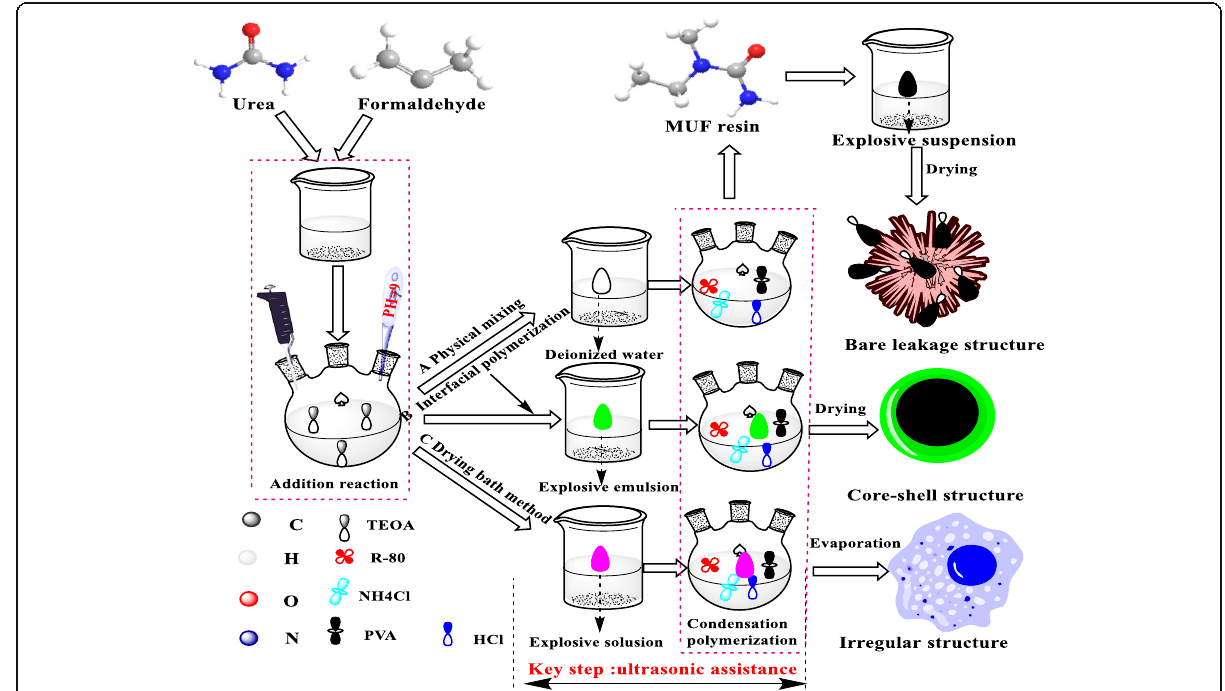
Fig. 2 Schematic diagram of different methods for preparing HMX/MUF, RDX/MUF, and